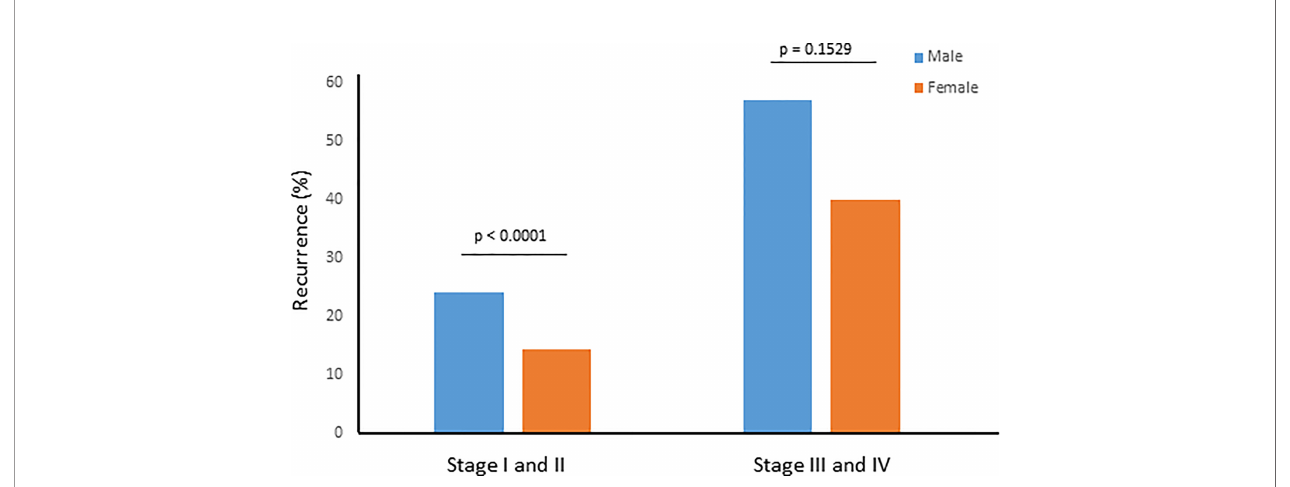
FIGURE 1 | Recurrence rate for male and female sex strati fi ed by tumor stage. Recurrence rate was signi fi cantly higher among men than women in early stage (I and II) tumors (24.2% vs. 14.4%; p < 0.0001), whereas the difference was not signi fi cant between male and female sex in late stage (III and IV) PTC (57.1% vs. 40.0%; p = 0.1529).